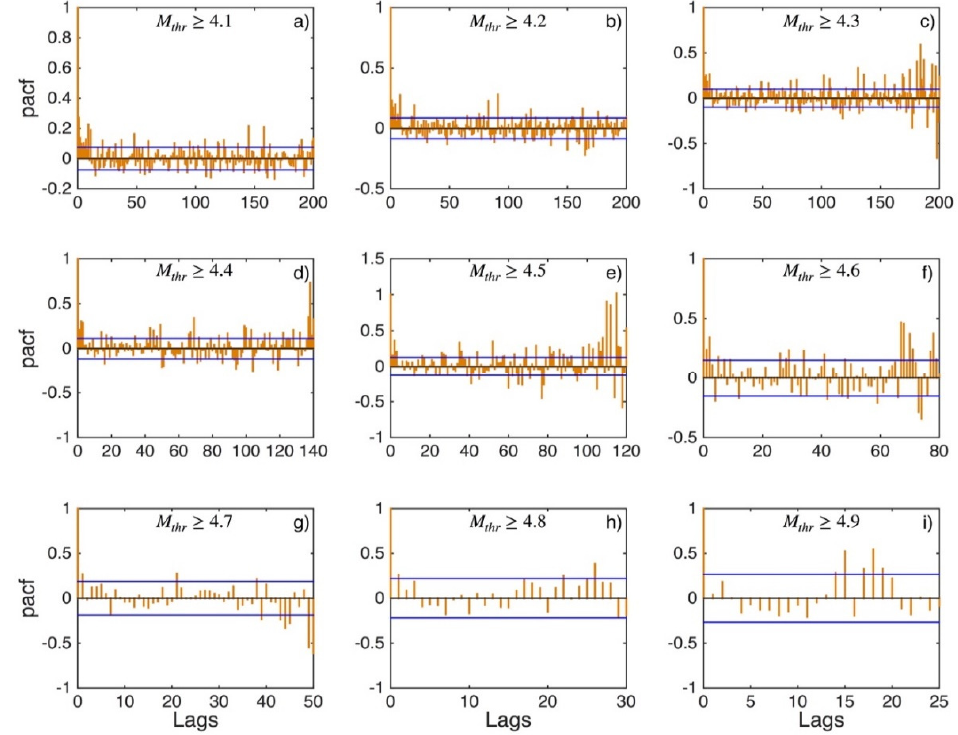
Figure A17. PACF values (orange stems) and their 95% confidence intervals (blue lines) for Corinth Gulf (sub − area 7) for magnitude thresholds ( M thr ) varying from 4.1 to 4.9 (subplots a – i ).